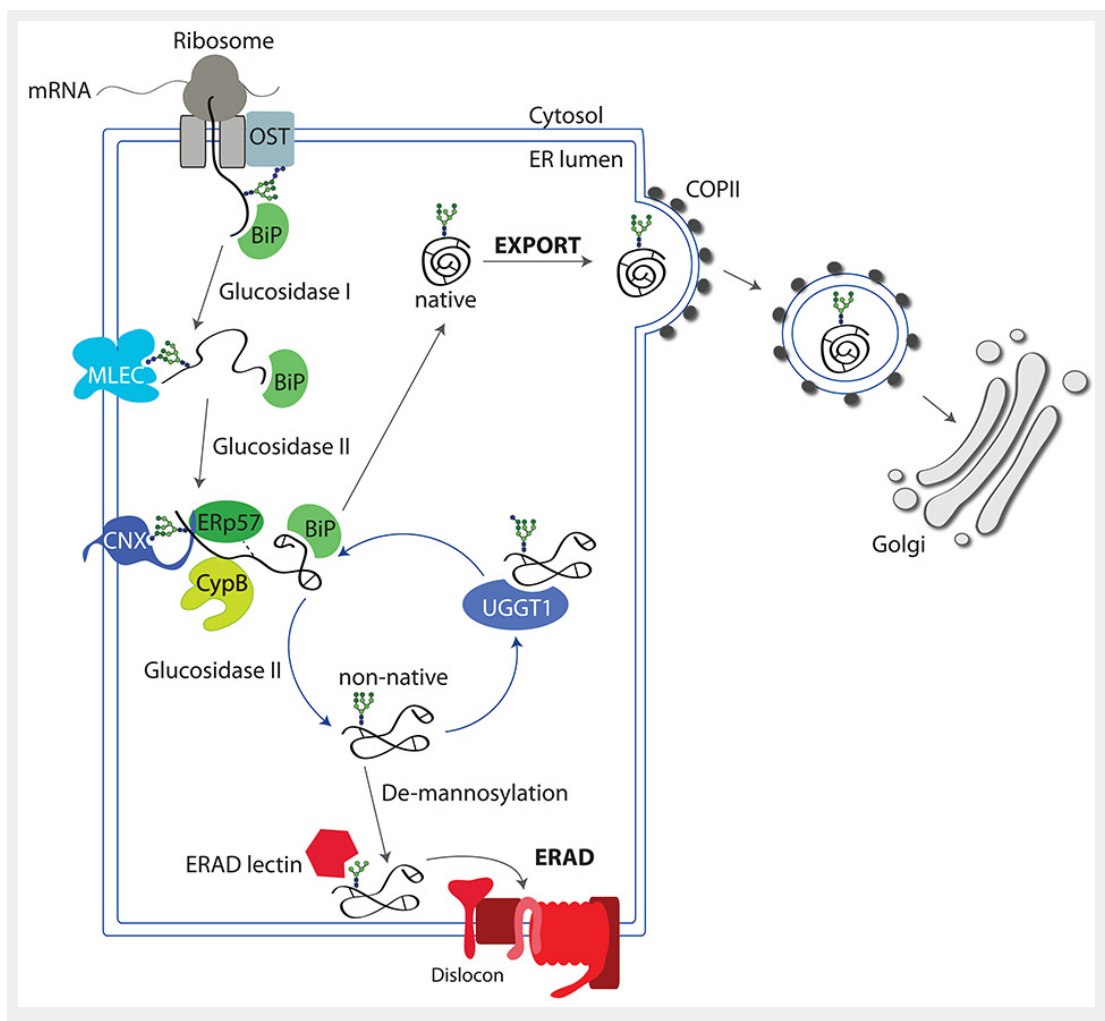
Figure 2 Folding cycle in the ER. The nascent polypeptide arising from the ribosome is translocated into the ER lumen. The polypeptide is co- translationally N-glycosylated by the OST. Hydrophobic patches exposed by the not-yet native polypeptide are shielded by molecular chaperones such as BiP to prevent aggregation. Upon removal of the outermost glucose residue by glucosidase I, the lectin malectin binds to the N-glycan. Removal of the second glucose residue by glucosidase II, allows recruitment of CNX (or CRT) and the associated folding enzymes (the oxidoreductase ERp57 and the peptidyl-prolyl cis/trans isomerase CypB that catalyse the rate-limiting steps of the folding programme leading to the attainment of the correct configuration of disulfide and peptidyl-prolyl bonds, respectively). The polypeptide is eventually released from CNX, the third glucose residue is removed by glucosidase II, and the polypeptide structure is inspected by the folding sensor UGGT1. Native proteins are exported to the Golgi in COPII-coated vesicles. Non-native polypeptides are re-glucosylated by UGGT1 and sent back to the CNX folding platform. Terminally misfolded polypeptides are extensively de-mannosylated and dislocated across the ER membrane to be degraded by cytosolic proteasomes in processes collectively defined as ER-associated degradation